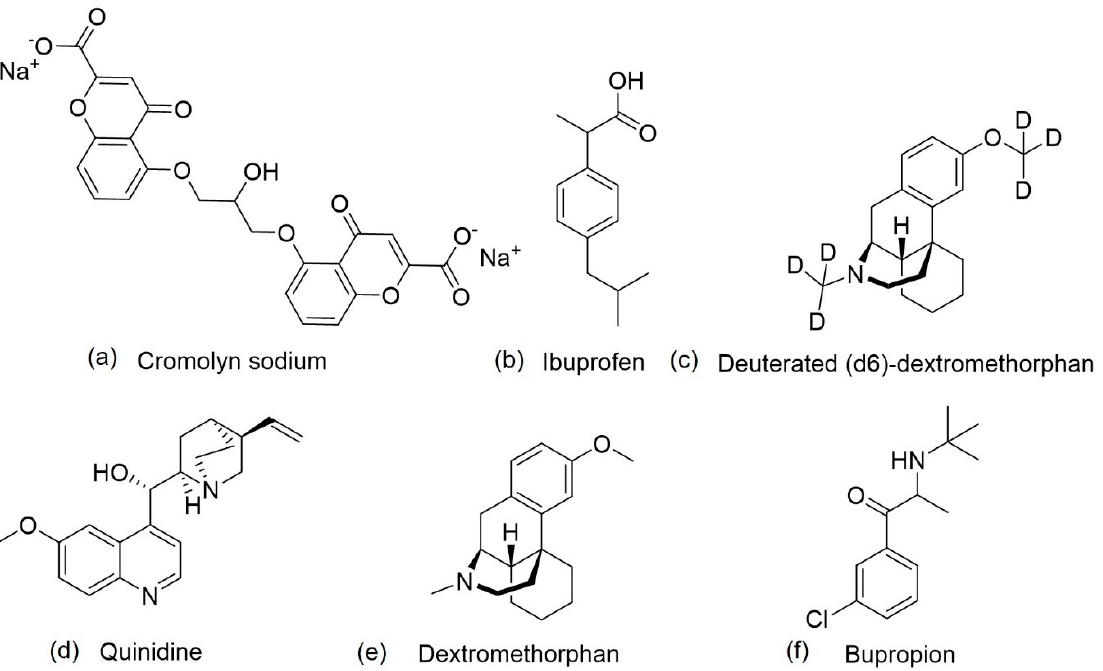
Figure 8. Chemical structures of agents that are being studied in phase III clinical trials, ( a ) cromolyn sodium, ( b ) ibuprofen, ( c ) deuterated (d6)-dextromethorphan, ( d ) quinidine, ( e ) dextromethorphan and ( f ) bupropion.